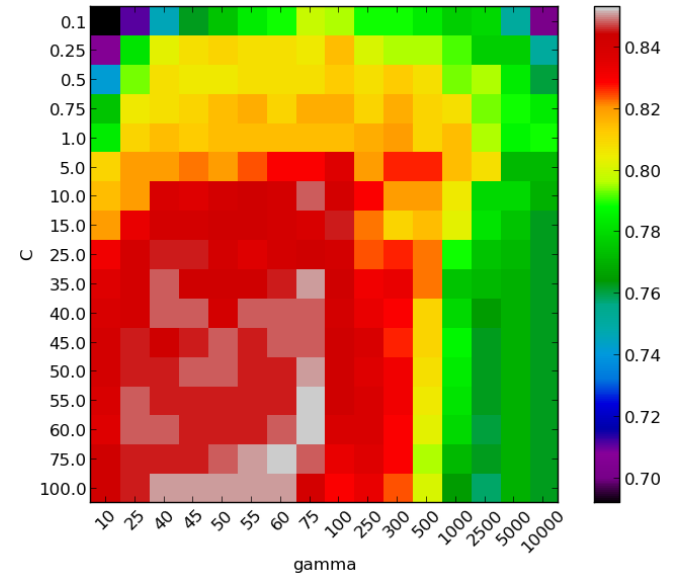
Figure 4. Accuracy values corresponding to the C and γ grid search, for the selected Support Vector Machines (SVM)